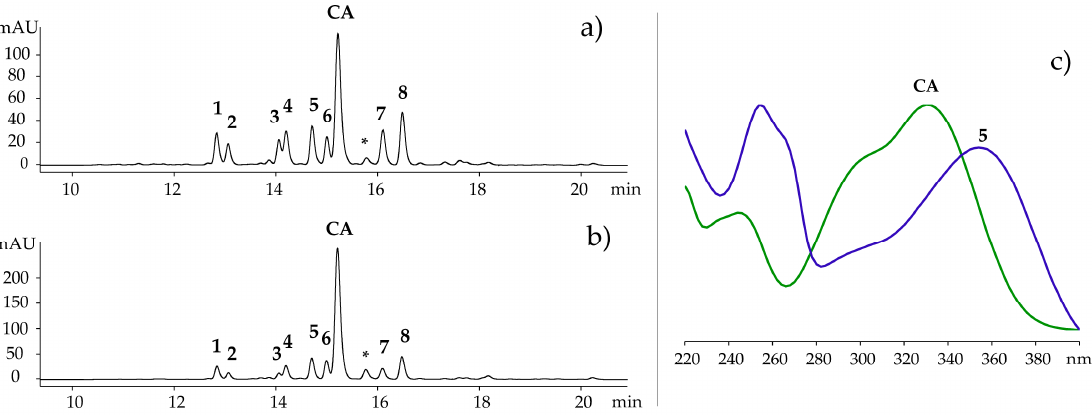
Figure 1. ( a – c ) HPLC chromatogram of Ruppia cirrhosa ( a ) and Ruppia maritima ( b ) recorded at 360 ± 10 nm; ( c ) UV-Vis spectrum of isorhamnetin 3- O- β - D -galactopyranoside ( 5 ) and chicoric acid ( CA ).